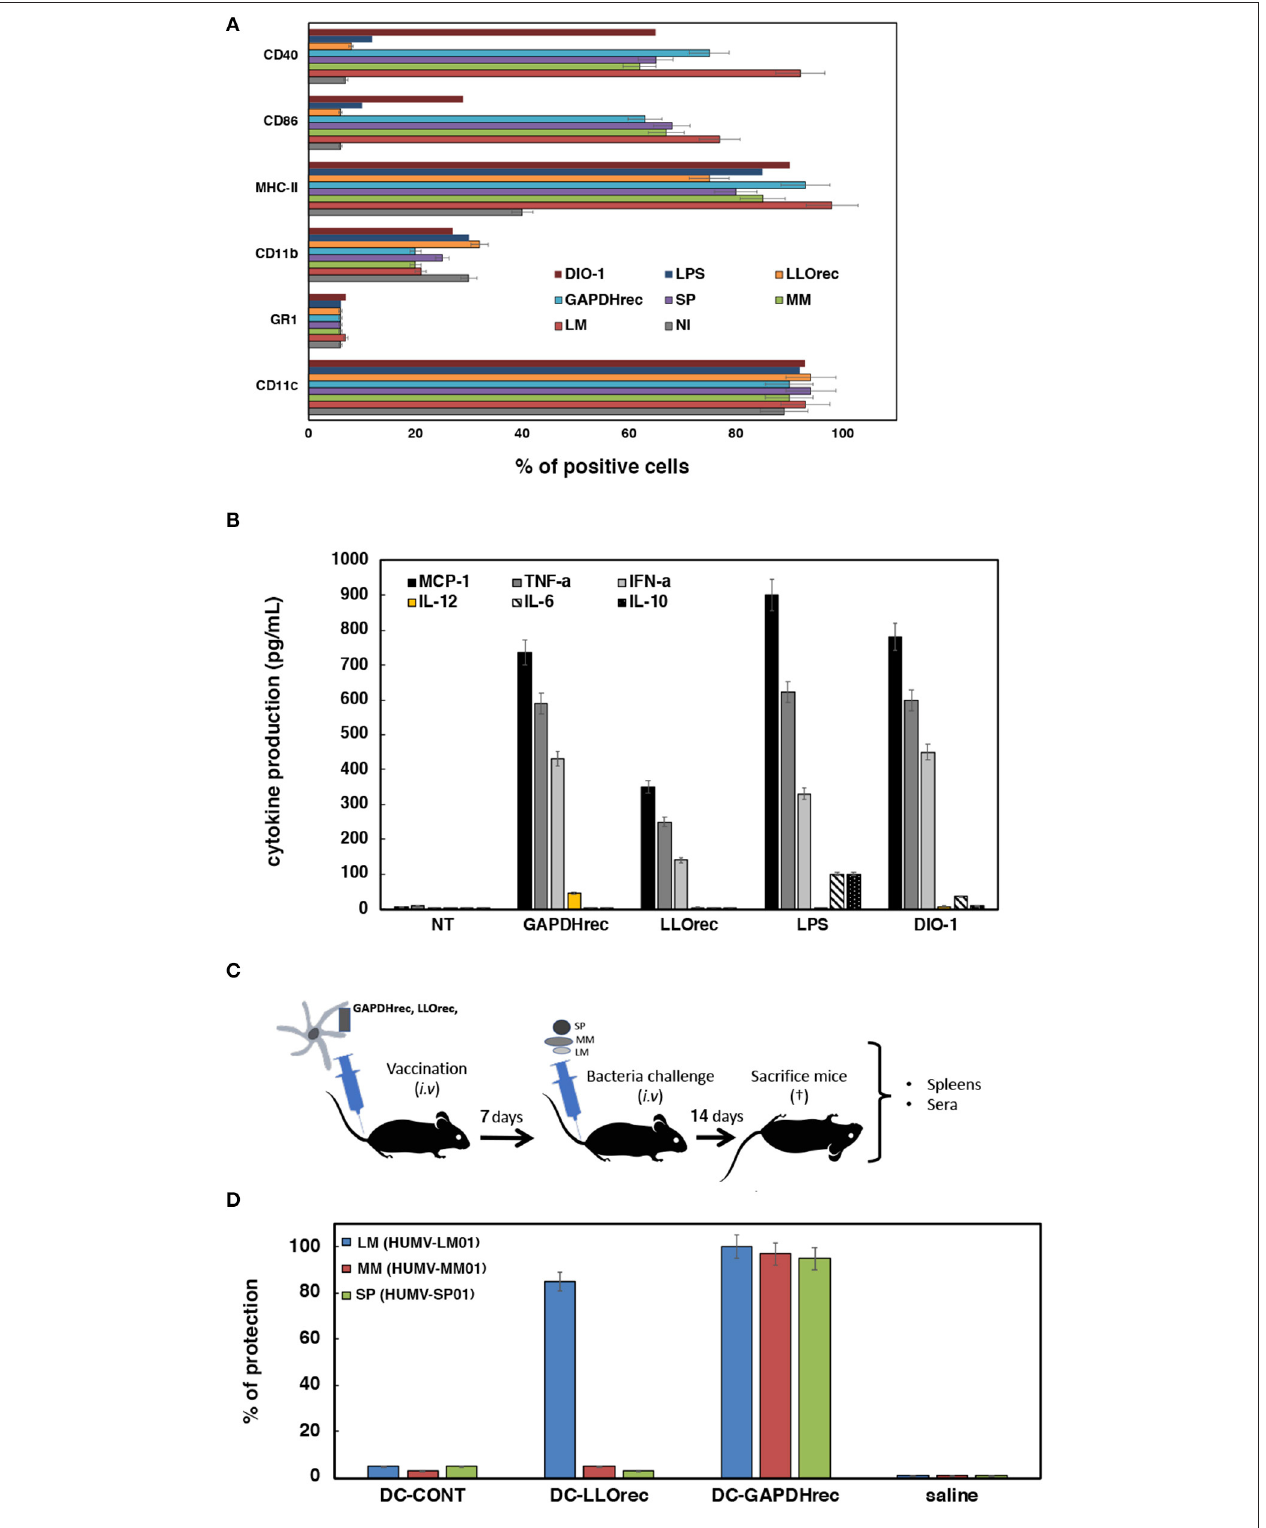
FIGURE 3 | Adjuvant and vaccine abilities of DC vaccine vectors loaded with recombinant or mRNA-LIPO antigens. (A) Flow cytometry analysis of DC surface markers after incubation with recombinant proteins LLO rec or GAPDH rec or mRNA-LIPO complexes: mRNA-LIPO-LLO, mRNA-LIPO-GAPDH, bacteria MM